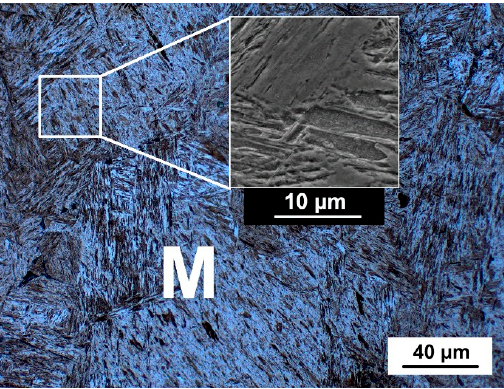
Figure 3. Martensite starting microstructure.